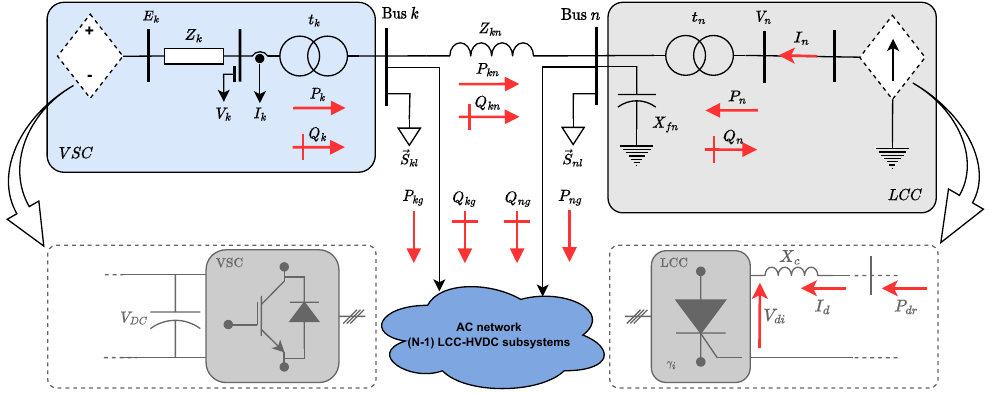
Figure 5. Representation of a three-bus hybrid multi-infeed